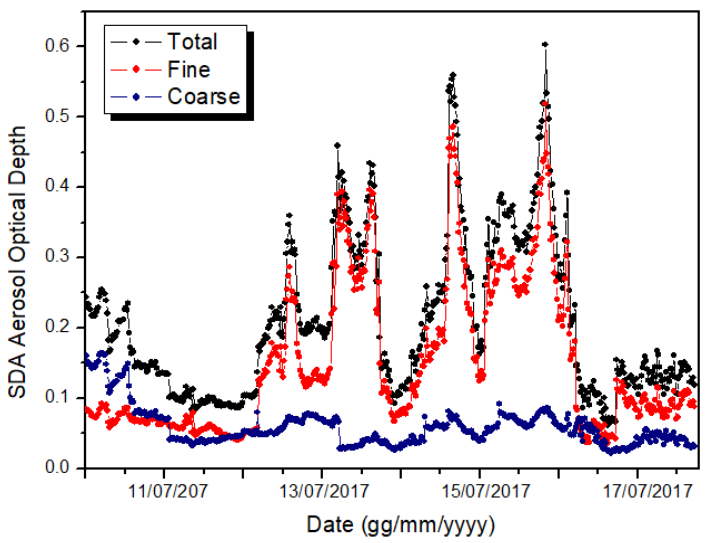
Figure 7. July 2017 fine and coarse mode AOD derived from AERONET spectral deconvolution algorithm (SDA) retrieval.